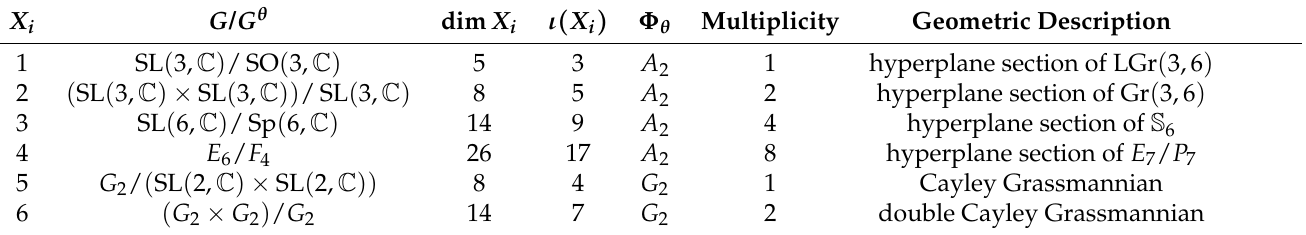
Table 1. Nonhomogeneous smooth projective symmetric varieties with Picard number one. X i G / G